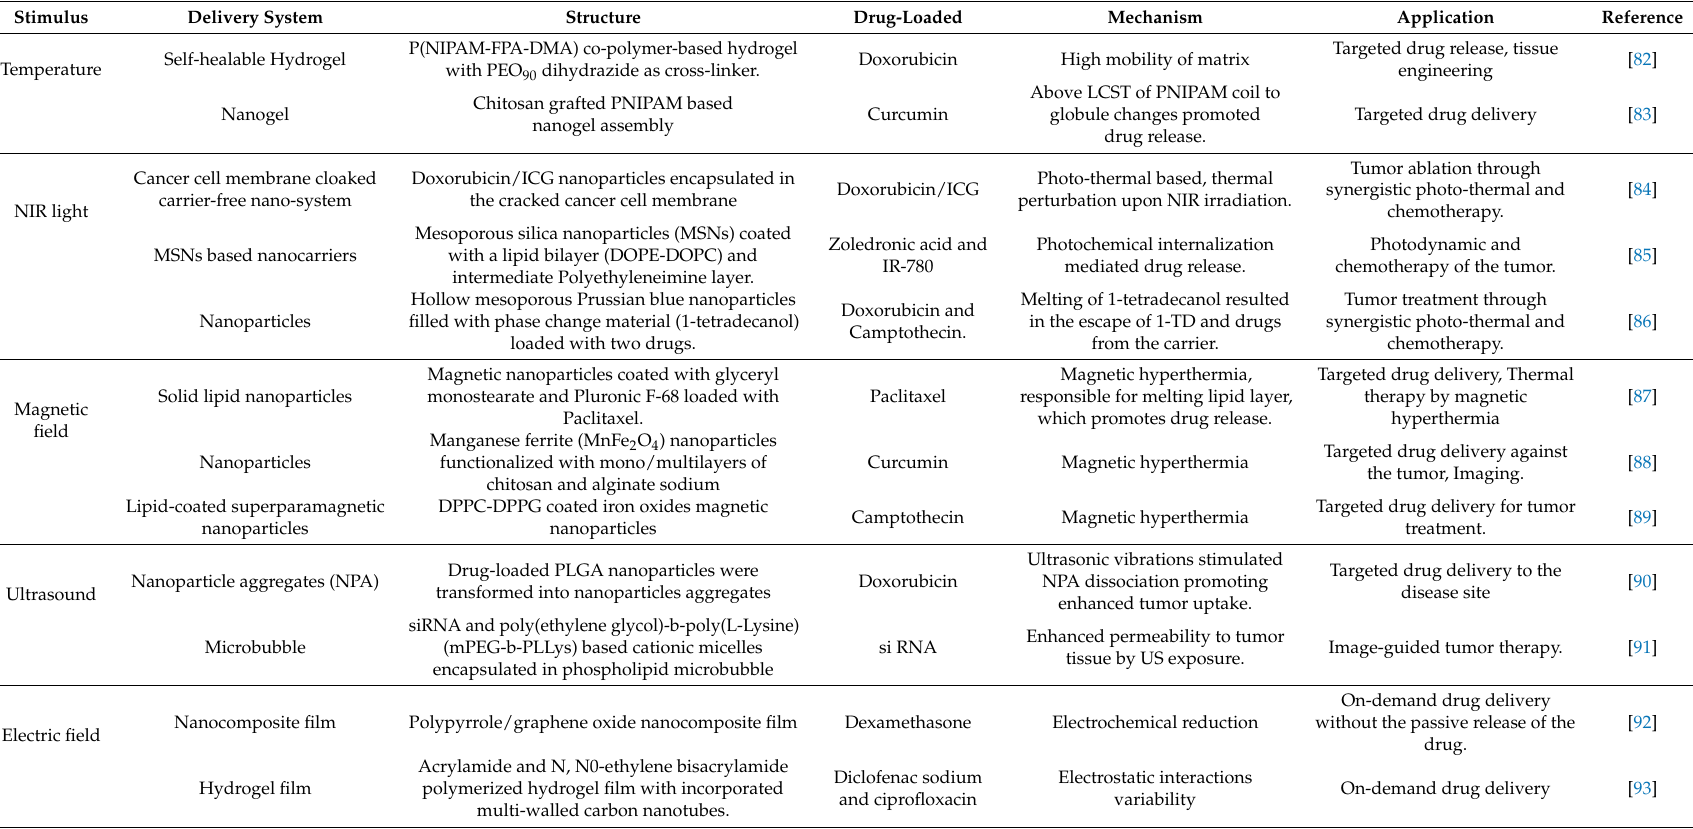
Table 1. Exogensous stimuli responsive